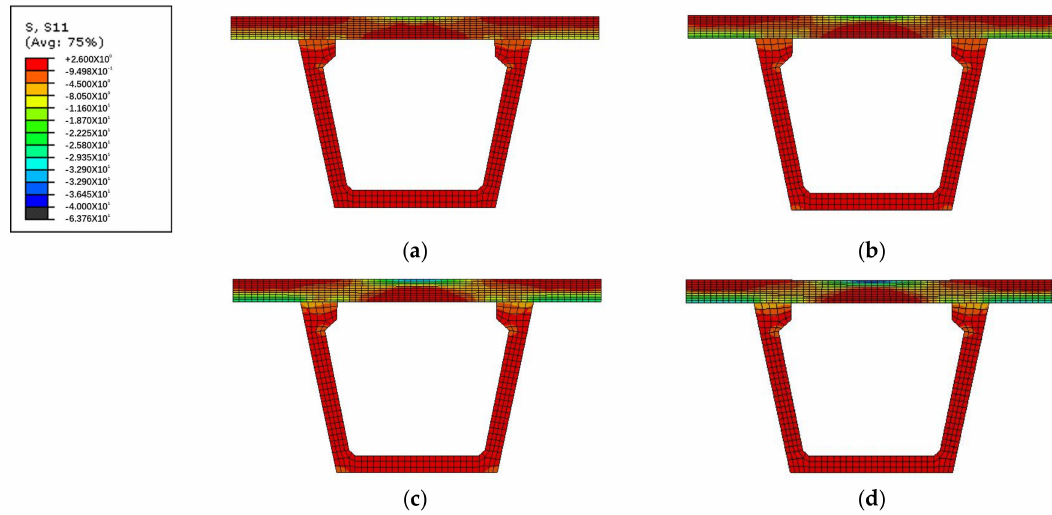
Figure 19. Transverse stress distribution for slab loading between the W-beams. ( a ) At 50% of the ultimate bearing capacity; ( b ) At 70% of the ultimate bearing capacity; ( c ) At 90% of the ultimate bearing capacity; ( d ) At 100% of the ultimate bearing